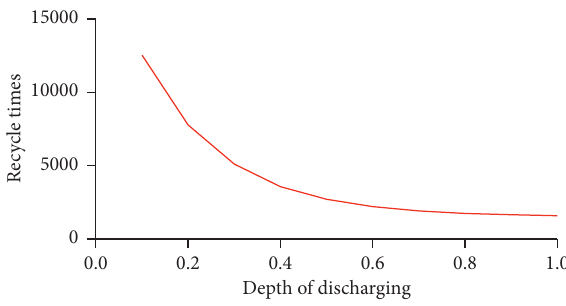
Figure 2: The relationship between N